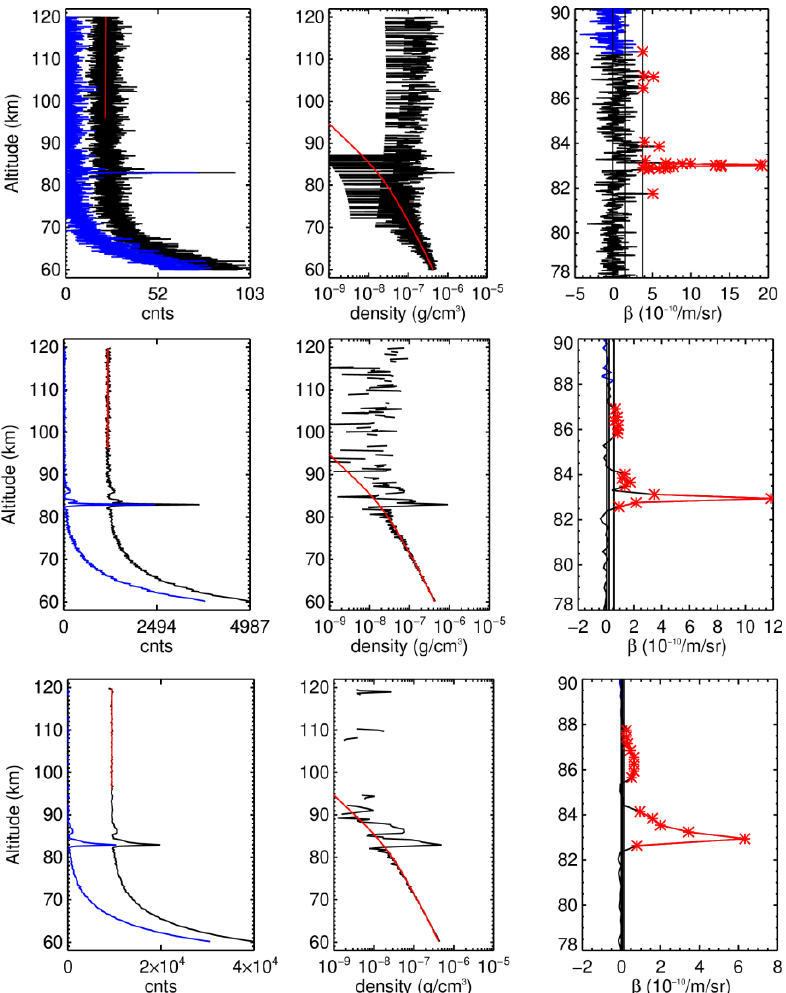
Figure 2. PMC signal centred on 11 July 2018, 01:35UT, processed at three different resolutions of 20m × 10s (top row), 180m × 1min (middle row), and 300m × 5min (bottom row). The left column shows the binned photon count profiles (black) and the same profiles with the background removed (blue). The red line represents the background model fitted between 96 and 120km altitude. The middle column shows the calculated backscatter profile (black) and fitted MSIS-E-90 model density profile (red). The right column shows derived volume backscatter coefficients β ( z ). The noise floor is estimated in the range 88–90km (blue). Vertical lines indicate the mean noise, standard deviation σ bg , and the used significance level 2.5 σ bg . Values with β ( z ) > 2 . 5 σ bg are marked in